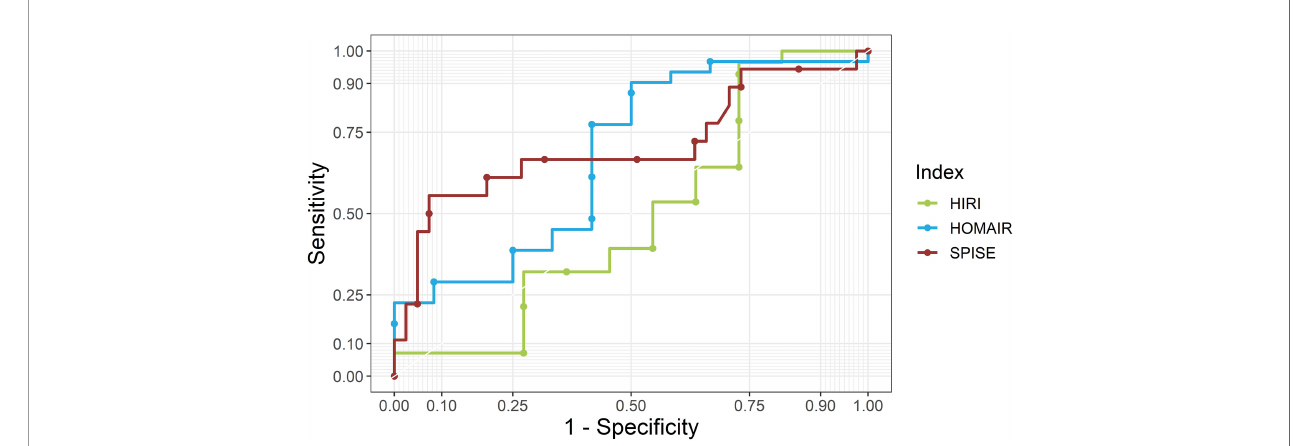
FIGURE 2 | ROC curves for SPISE, HOMA-IR and HIRI for male patients. SPISE, Single Point Insulin Sensitivity Estimator; HOMA-IR, homeostatic Model Assessment for Insulin Resistance; HIRI, Hepatic Insulin Resistence Index.